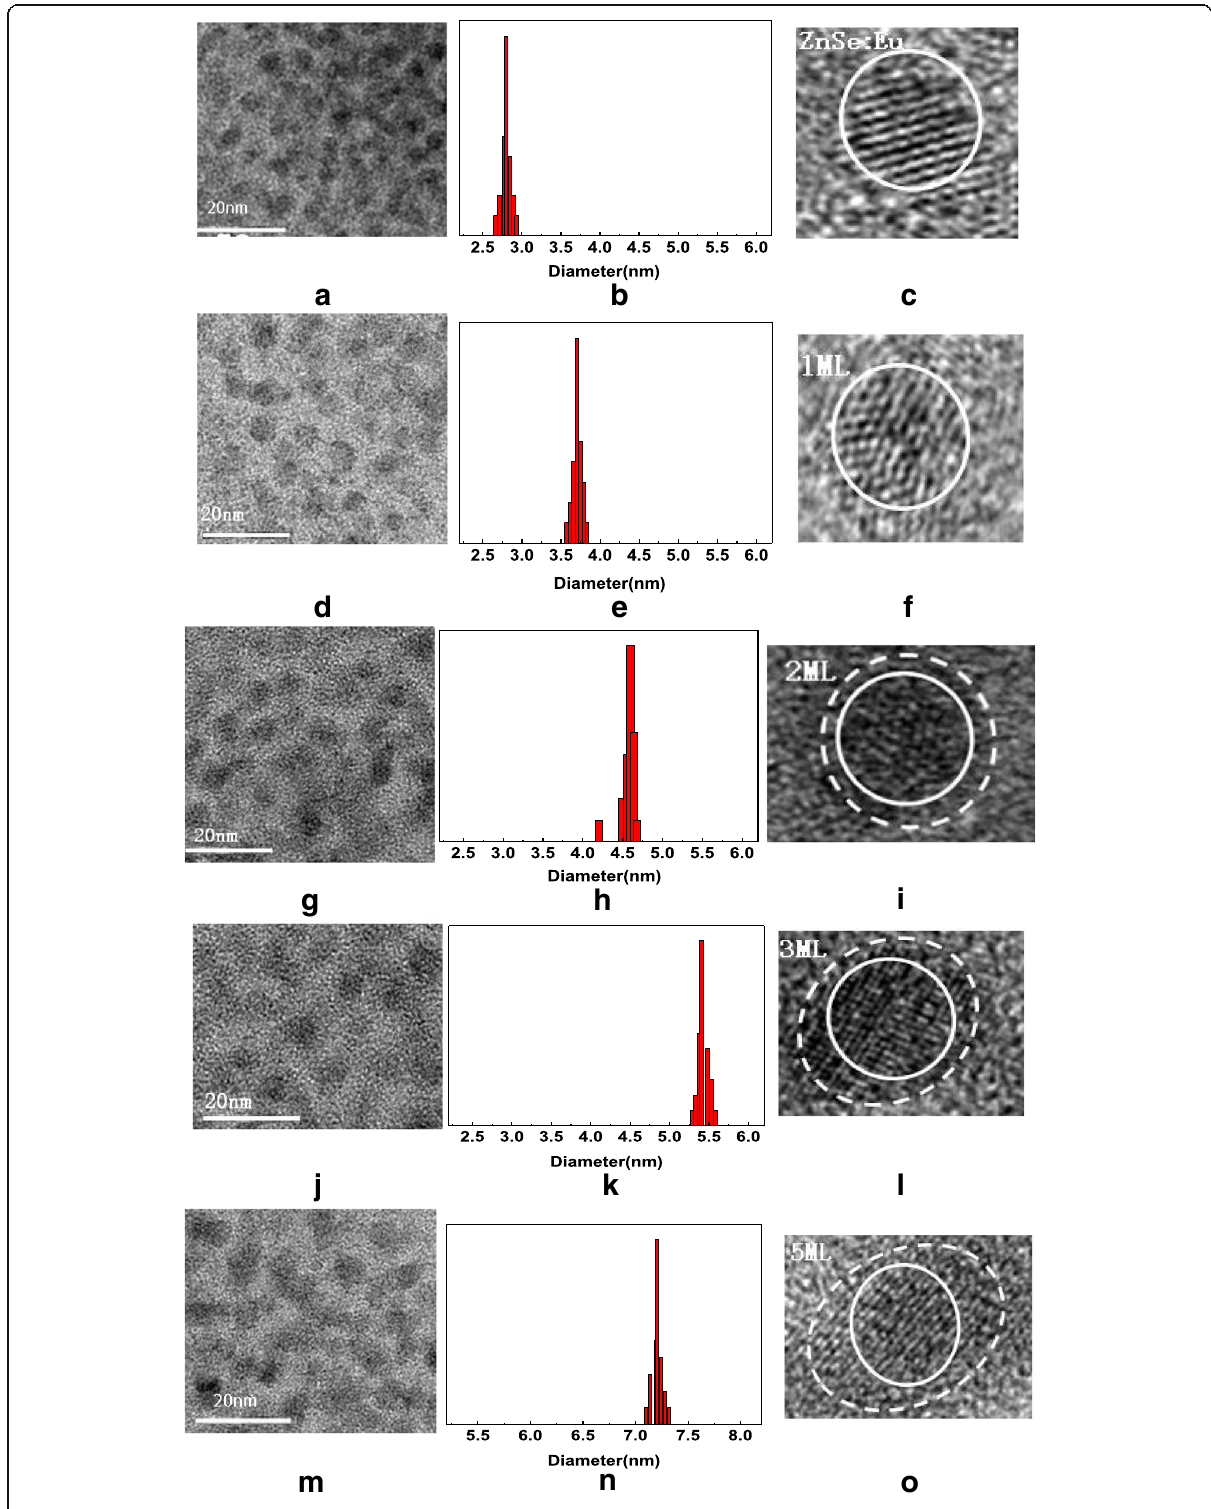
Fig. 1 TEM images and histograms of the measured particle sizes of ZnSe:Eu QDs ( a , b ) and overcoated with 1 ML ( d , e ), 2 ML( g , h ), 3 ML ( j , k ), and 5 ML ( m , n ) of the ZnS shell, respectively. Cryo-HRTEM of core ZnSe:Eu ( c ) images and the corresponding core-shell ZnSe:Eu /ZnS QDs with 1 ML ( f ), 2 ML ( i ), 3 ML ( l ), 5 ML ( o ) shell,